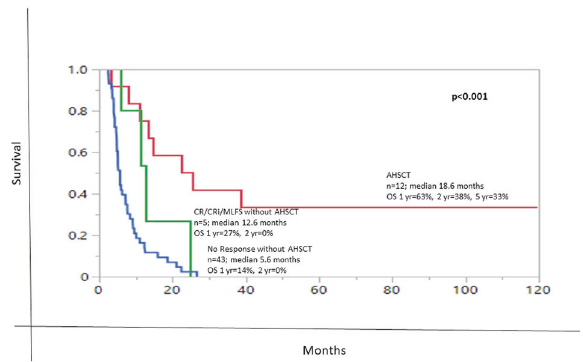
Fig. 1 Overall survival (OS) strati fi ed by AHSCT (allogeneic hematopoietic stem cell transplant).